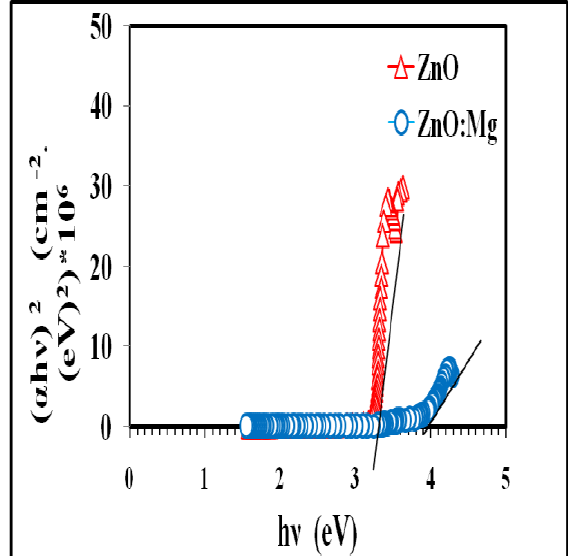
Fig.4: Varaition of (αhʋ) 2 with photon energy (hʋ) of the ZnO pure and